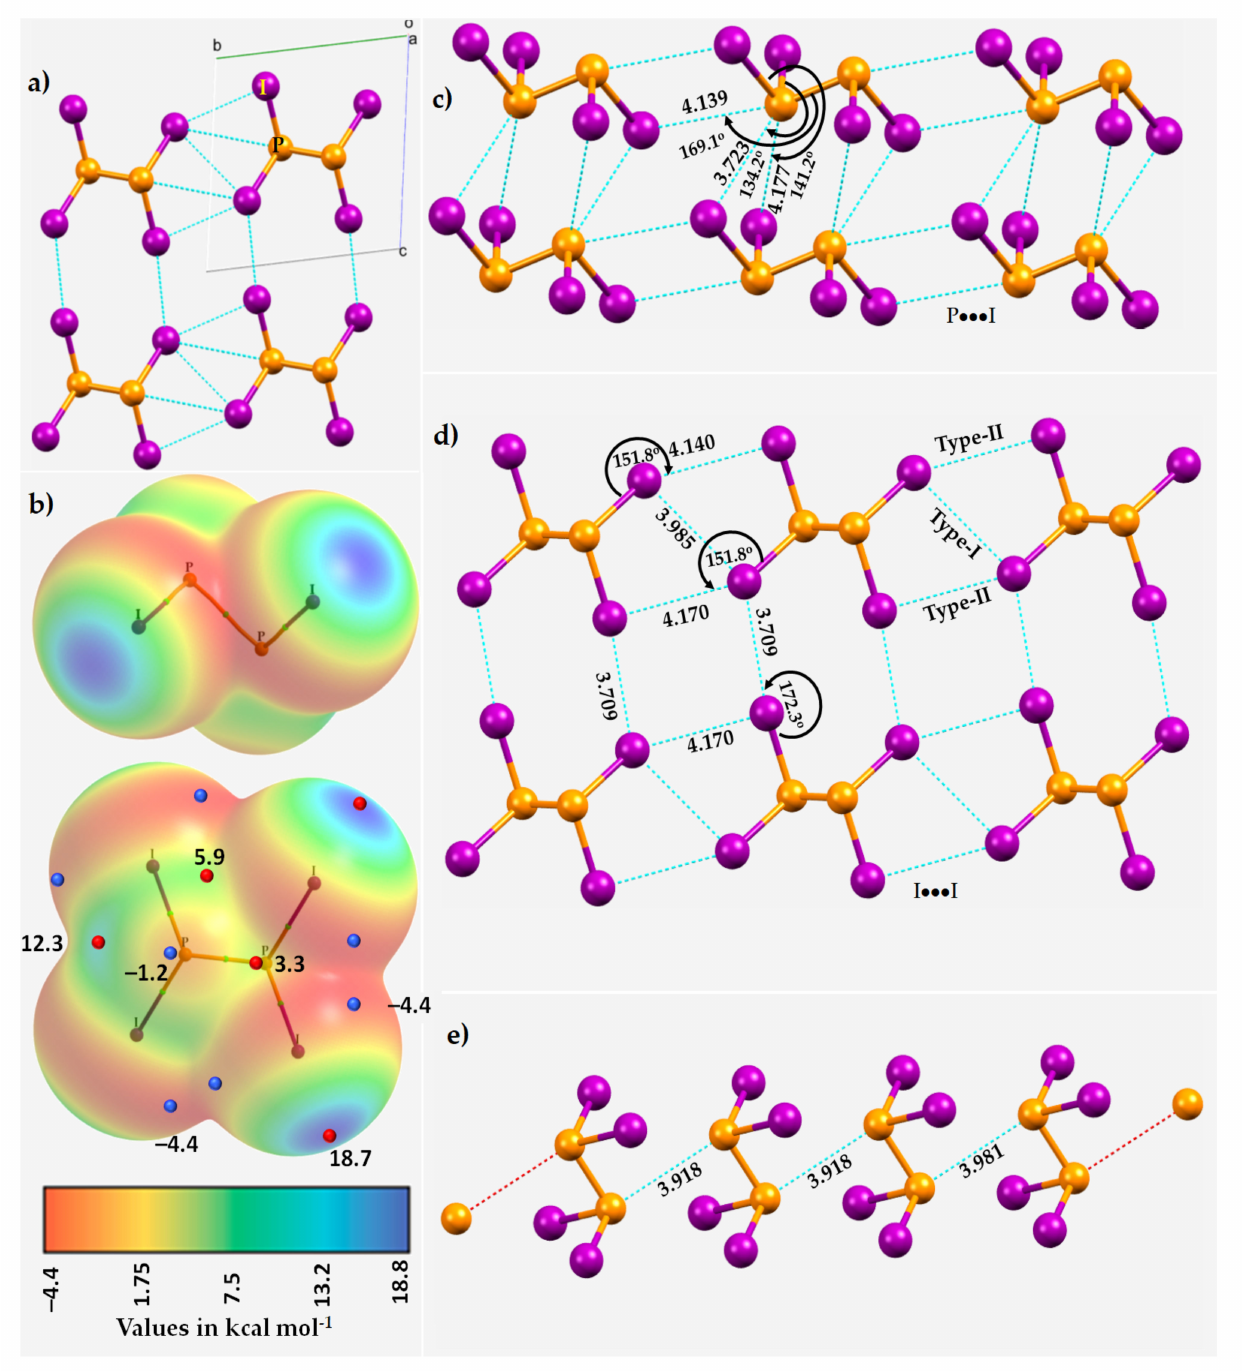
Figure 14. ( a ) The 2 × 2 × 2 supercell structure of the crystal structure of diphosphorus tetraiodide (ICSD ref. code 36293) [116] (space group P1). ( b ) The MP2(full)/def2-TZVPPD level 0.001 a.u. isoden- sity envelope mapped potential on the electrostatic surface of the P 2 I 4 molecule, with selected local maxima and minima of potential marked by tiny red and blue spheres, respectively. ( c – e ) Illustration of the nature of P ··· I, I ··· I, and P ··· P intermolecular interactions in the crystal. Atom type is shown in ( a ). Selected bond distances and bond angles are in Å and degrees, respectively. The Type-II I ··· I directional contacts locally form I 4 -type structures (Figure 14d). There are four such contacts that are σ -hole centered. Two of them have a bond distance of 3.709 Å, while the other two are substantially longer, with a distance of 4.170 Å. The